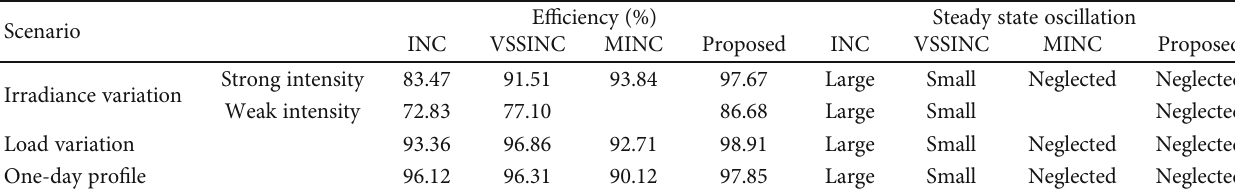
Table 3: Tracking time and power loss comparison of the proposed technique with other techniques. Scenario Irradiance variation